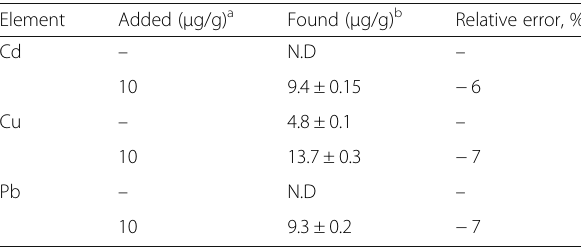
Table 3 Determination of Cd, Cu, and Pb in tomato leaves (0.5 g) Element